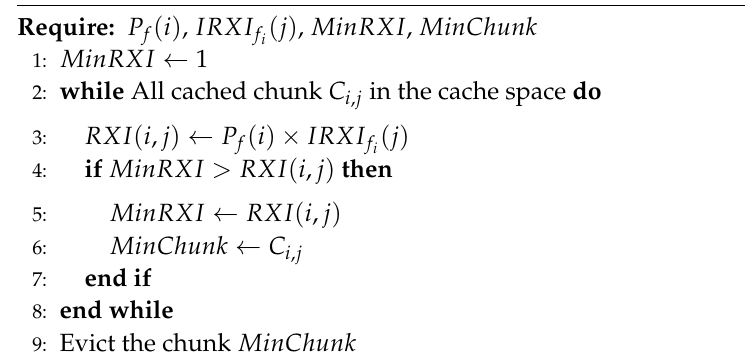
Algorithm 2 RXI-based Cache Replacement